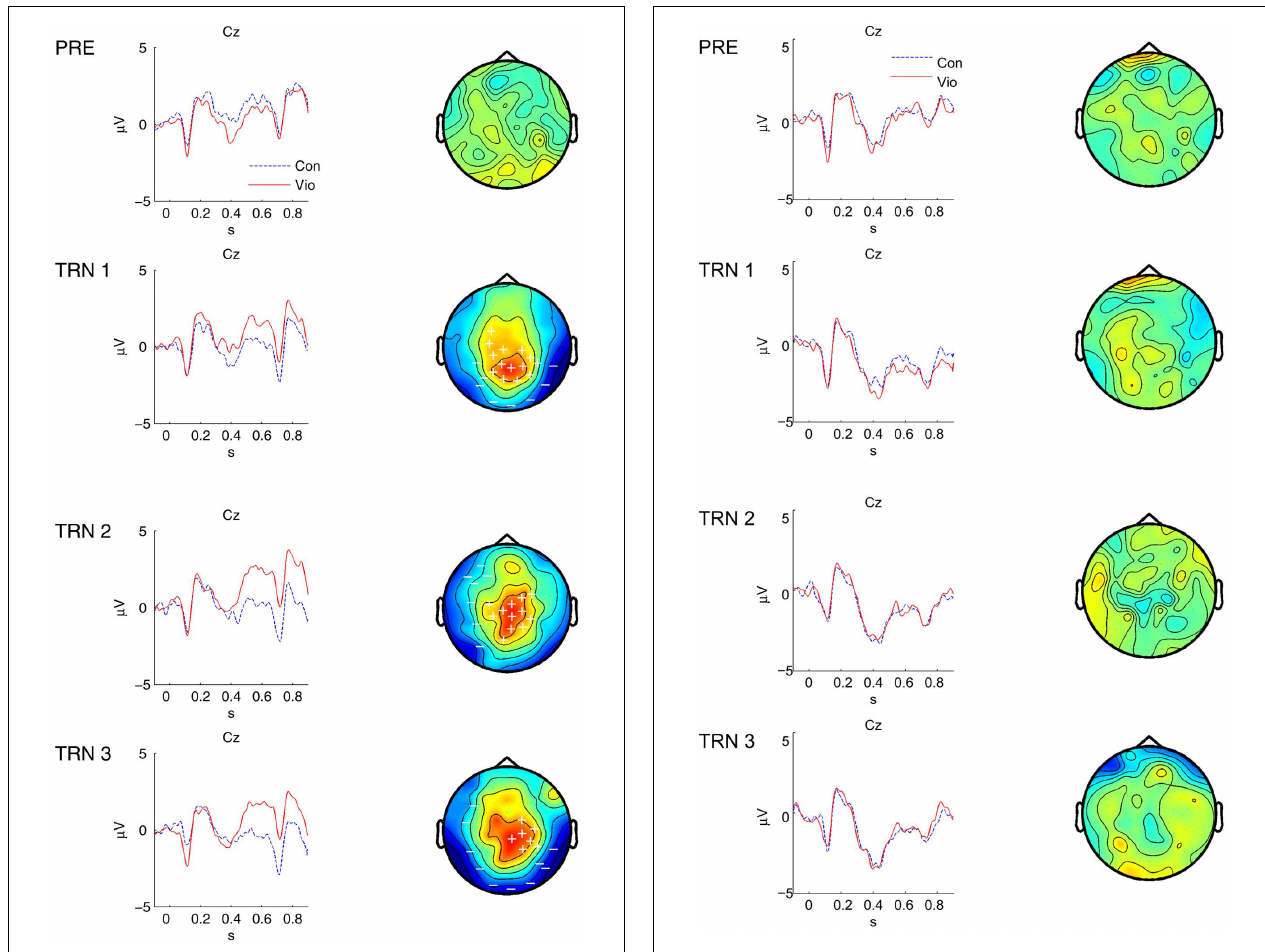
FIGURE 4 |Average event-related potentials for declension violation contrast (4 word). Trace plots indicate average voltage (in μ V) as a function of time at Cz/1; control = Con, violation = Vio. Symbols plotted on the topographical plots indicate membership within a statistically significant negative (“ − ”) or positive (“ + ”) cluster of electrodes.Topographical plots are viewed from the top (left is on the left-hand side).